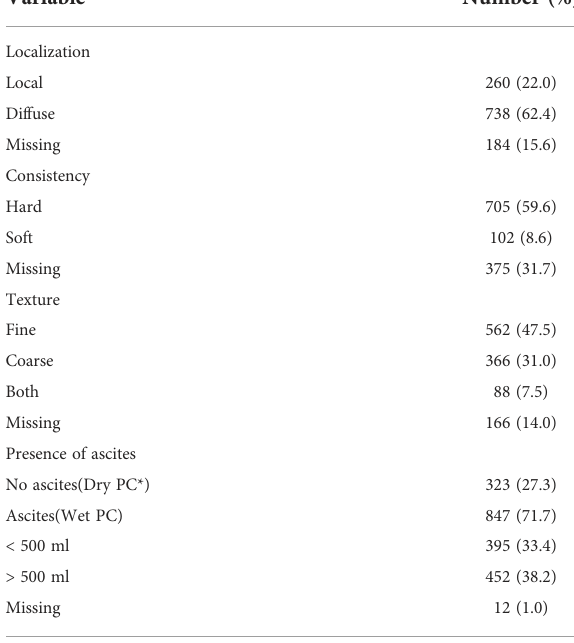
TABLE 2 Characteristics of peritoneal carcinomatosis (n=